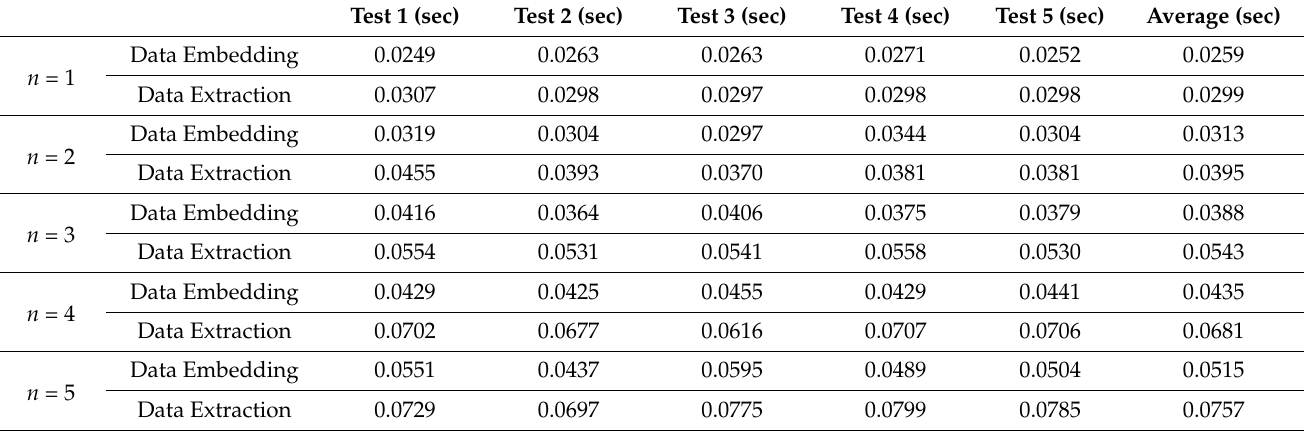
Table 9. Comparison of data hiding and extraction process speed tests of the proposed algorithm.